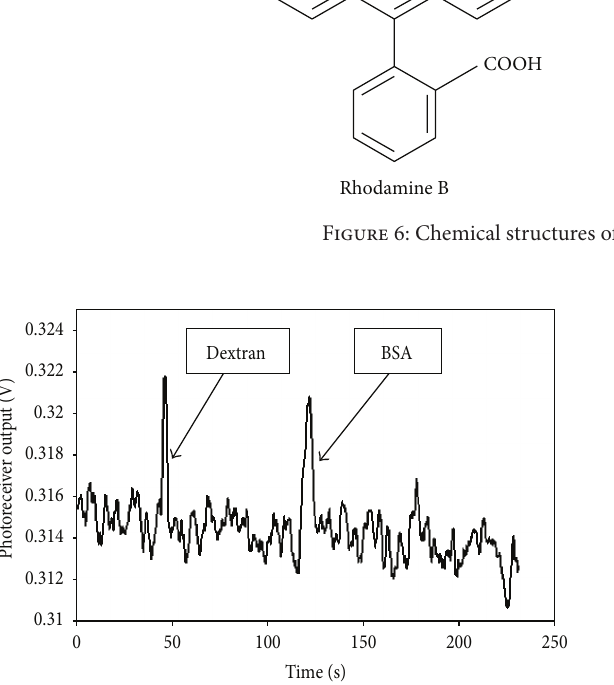
Figure 7: Biomolecule elution profile from the silica column with methanol mobile-phase at a flow rate of 0.23 𝜇 L/s. Dextran was eluted prior to